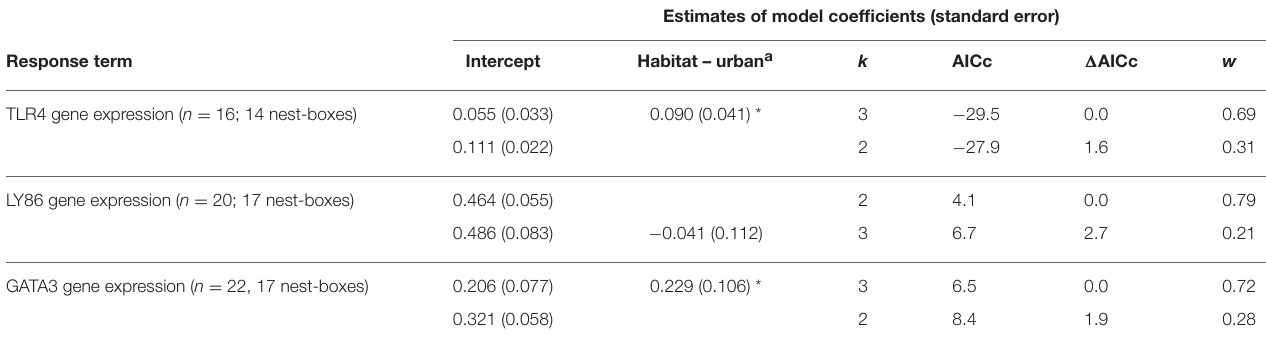
TABLE 2 | Summarizing table of statistical models employed to explain variation in TLR4, LY86, and GATA3 transcript levels for adult blue